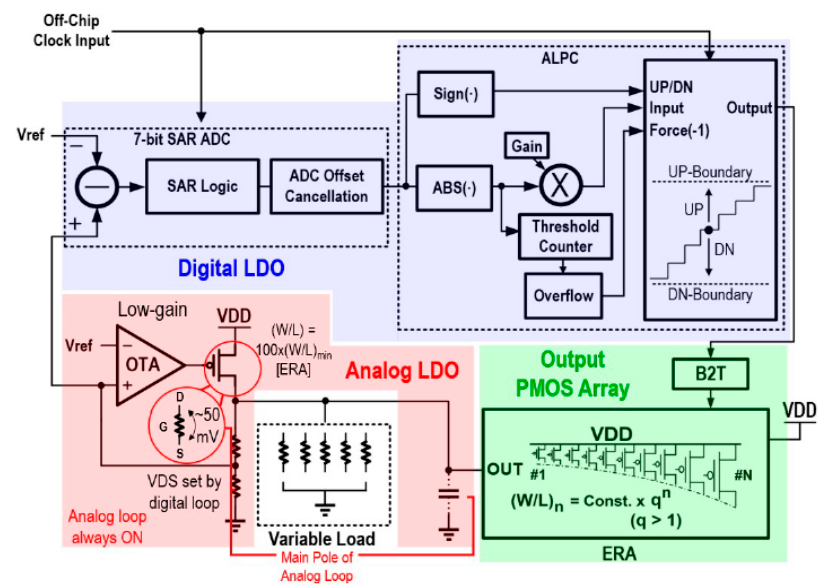
Figure 36. Exponential-Ratio Array (ERA)-based HD-LDO [62].